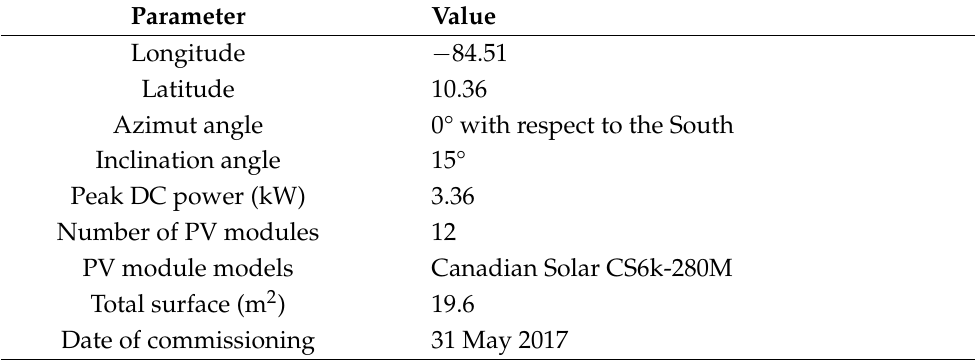
Table 2. Information about the PV arrays under study.